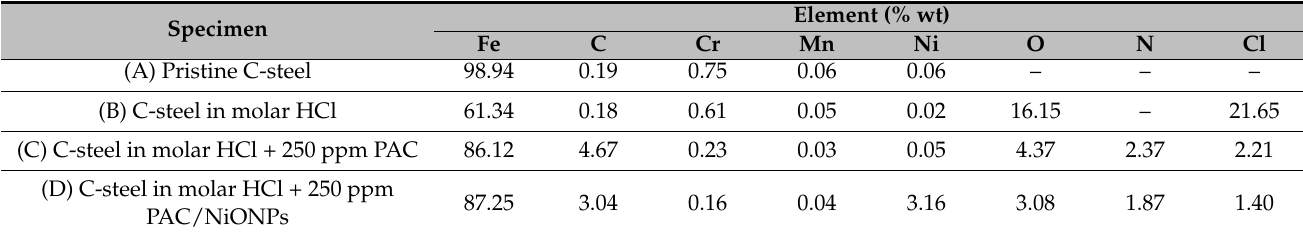
Figure 11. FE-SEM (I) and EDX (II) analyses for ( A ) pristine C-steel, ( B ) corroded C-steel in blank HCl, ( C ) C-steel with the occurrence of 250 ppm PAC and ( D ) C-steel with the presence of 250 ppm PAC/NiONPs. Table 5. The element percentage for each sample obtained from the EDX analysis after 48 h immersion in molar hydrochloric